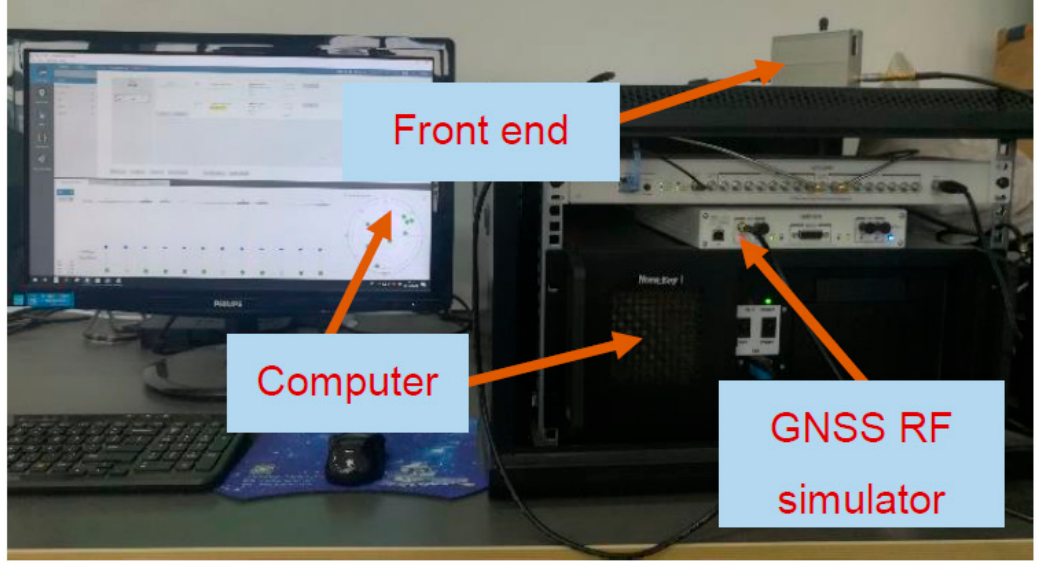
Figure 5. Global Positioning System (GPS) radio frequency (RF) signal simulation and digital intermediate frequency (IF) signal acquisition. Table 2. RF front-end main parameters.